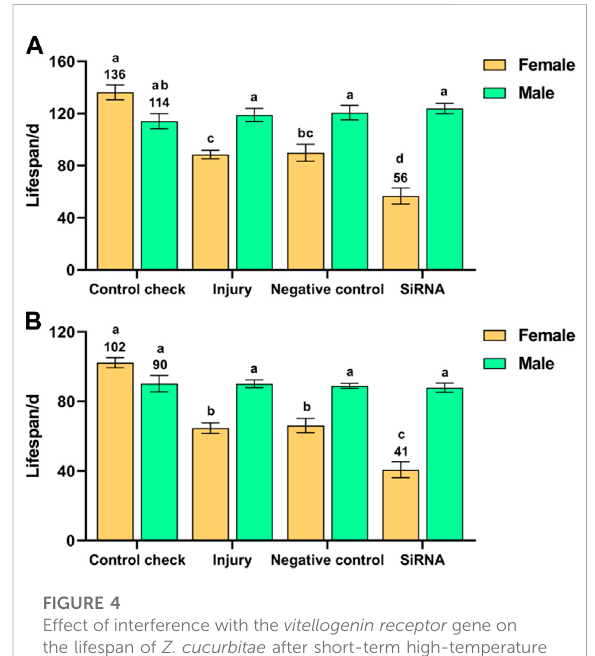
FIGURE 4 Effect of interference with the vitellogenin receptor gene on the lifespan of Z. cucurbitae after short-term high-temperature treatment. (A) Interference with the vitellogenin receptor gene after 25 ° C treatment for 1 h. (B) Interference with the vitellogenin receptor gene after 45 ° C treatment for 1 h. The columnsinthe fi gurerepresentthemean±standarderror,andthe letters above them indicate signi fi cant differences ( p ≤